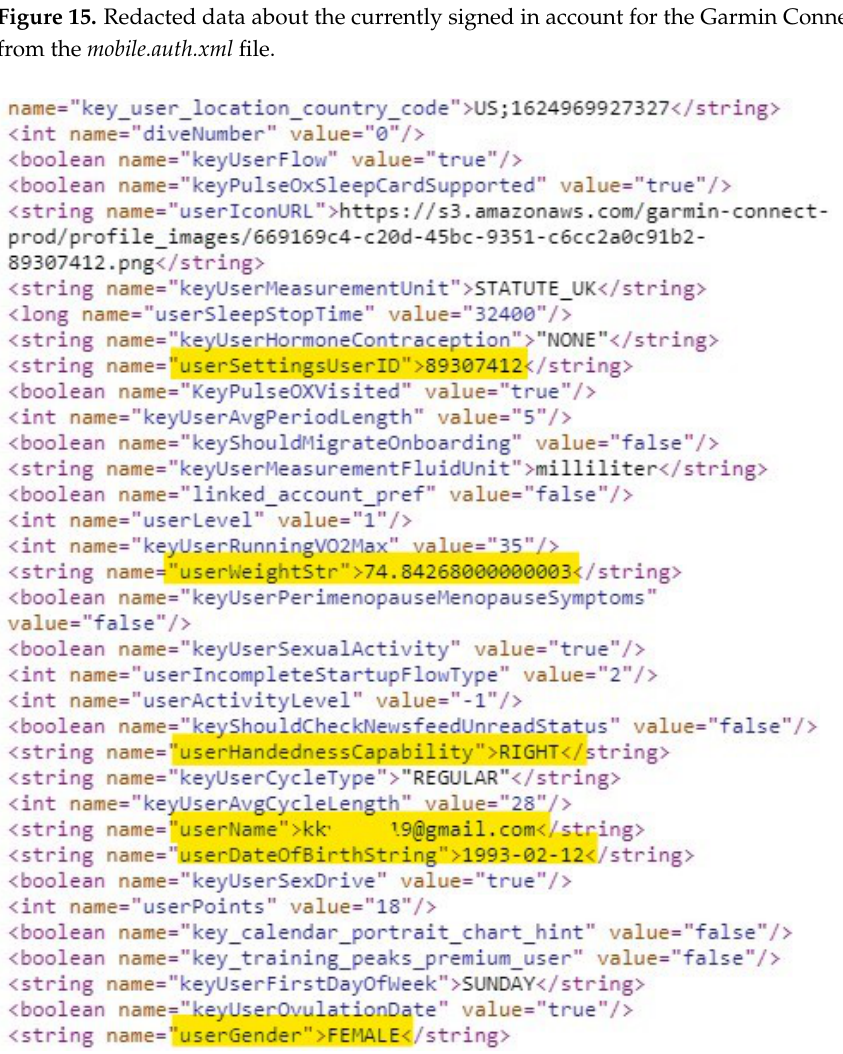
Figure 16. Redacted and reduced user profile information for the Garmin Connect